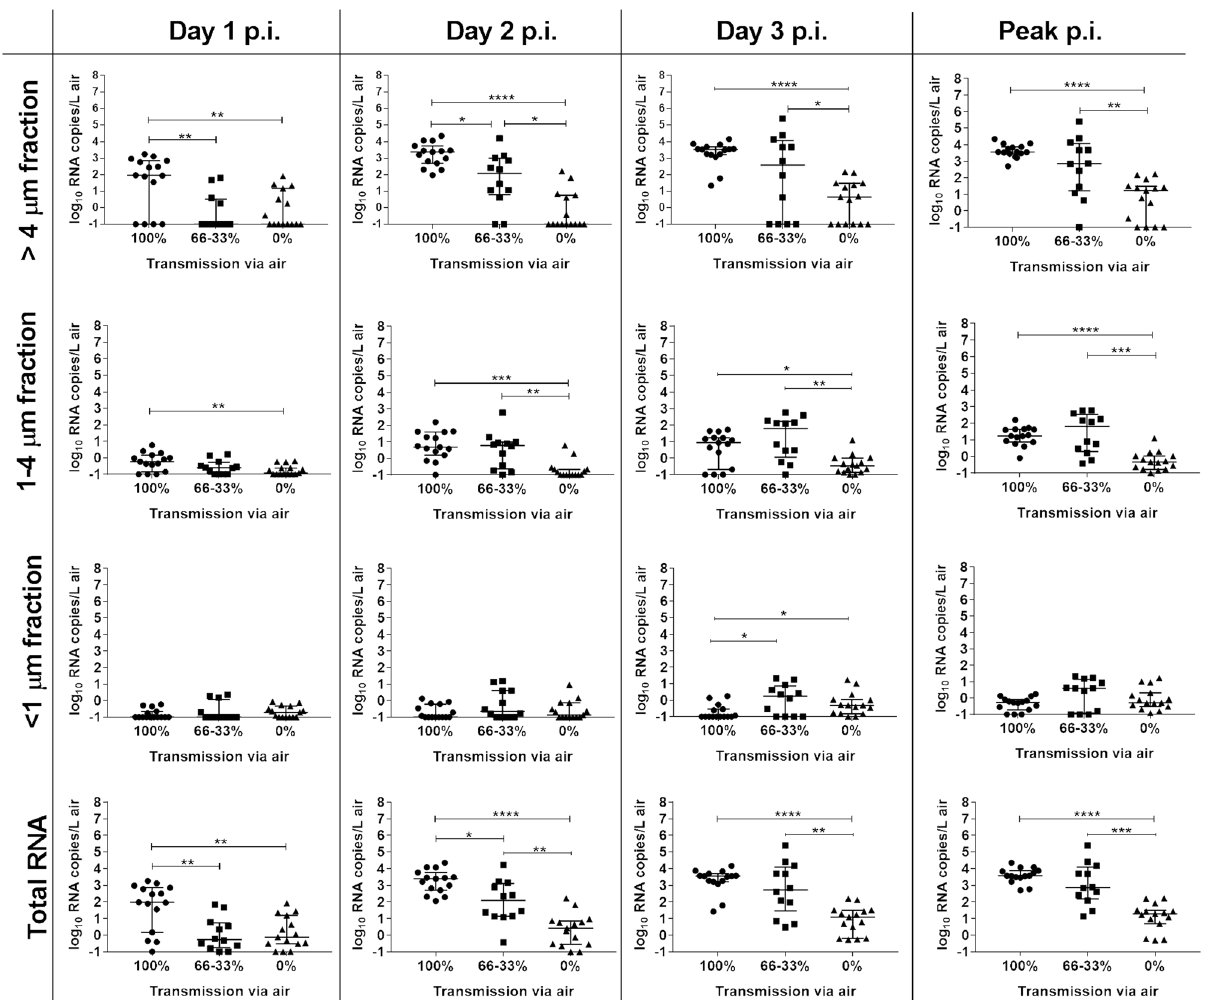
Fig. 5 Detection of in fl uenza A virus genomic RNA in size-fractioned air samples collected from ferrets. Viral RNA copies in particle size-fractionated air samples collected from inoculated ferrets on days 1-3 and peak viral RNA copies are shown (total RNA is inclusive of all size fractions). Viruses were grouped by transmissibility pro fi le in the ferret model (100%-transmission between all ferret pairs [A/Idaho/07/2018 A(H1N1)pdm09, A/Michigan/45/ 2015 A(H1N1)pdm09, A/Nebraska/14/2019 A(H1N1)pdm09, A/Michigan/288/2019 A(H1N1)v, A/Minnesota/45/2016 A(H1N2)v (3 ferrets per virus; n = 15)], 66 – 33% — transmission between 1/3 or 2/3 ferret pairs [A/Anhui-Lujiang/39/2018 A(H9N2), A/California/62/2018 A(H1N2)v, A/Ohio/24/ 2017 A(H1N2)v, A/Ohio/09/2015 A(H1N1)v (3 ferrets per virus; n = 12)], 0% — no transmission via air or inef fi cient direct contact transmission if airborne transmission was not tested [A/Ohio/02/2007 A(H1N1)v, A/turkey/California/18-031151-4/2018 A(H7N3), A/Sichuan/26221/2014 A(H5N6), A/ Yunnan/14563/2015 A(H5N6), A/duck/Bangladesh/19D770/2017 A(H5N6) (3 ferrets per virus; n = 15)]. Kruskal – Wallis one-way analysis of variance (ANOVA) with Dunn ’ s post-test was used to determine signi fi cant differences, * p < 0.05, ** p < 0.01, *** p < 0.001, **** p < 0.0001. Data points represent individual ferrets. Error bars represent the median with interquartile